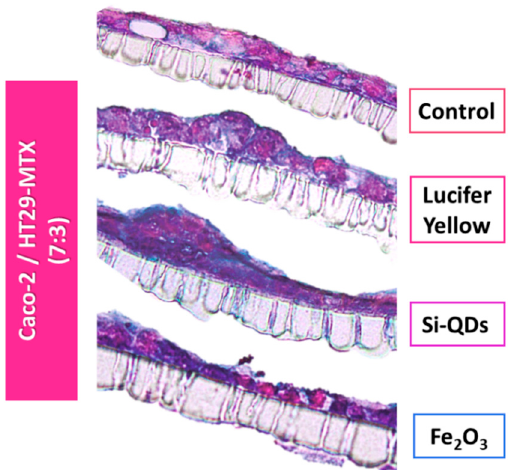
Figure 6. Insert cross-sections of the Caco-2/HT29-MTX intestinal model seeded at a 7:3 ratio following a 3-h exposure to nanoparticles. The cells were stained with 1% Alcian Blue/0.1% eosin in order to detect mucin production. Monolayer disruptions of the experimental groups are visible compared with controls.